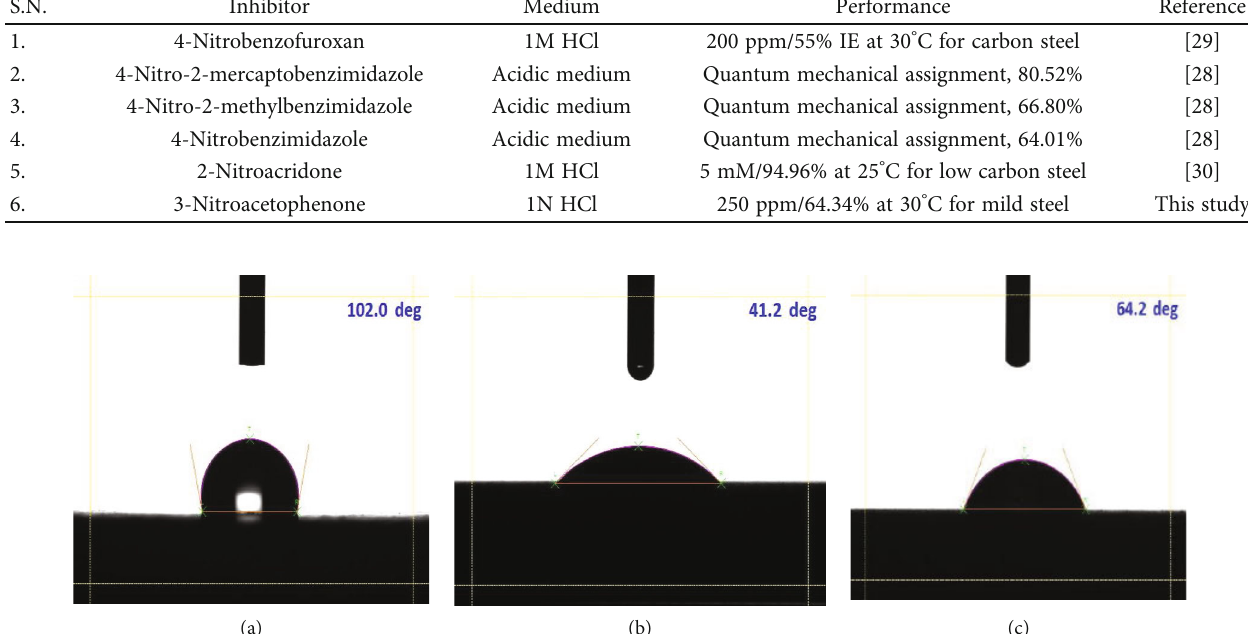
Table 5: Comparison of nitro compounds on inhibition e ffi ciencies of steel in acid medium. S.N.